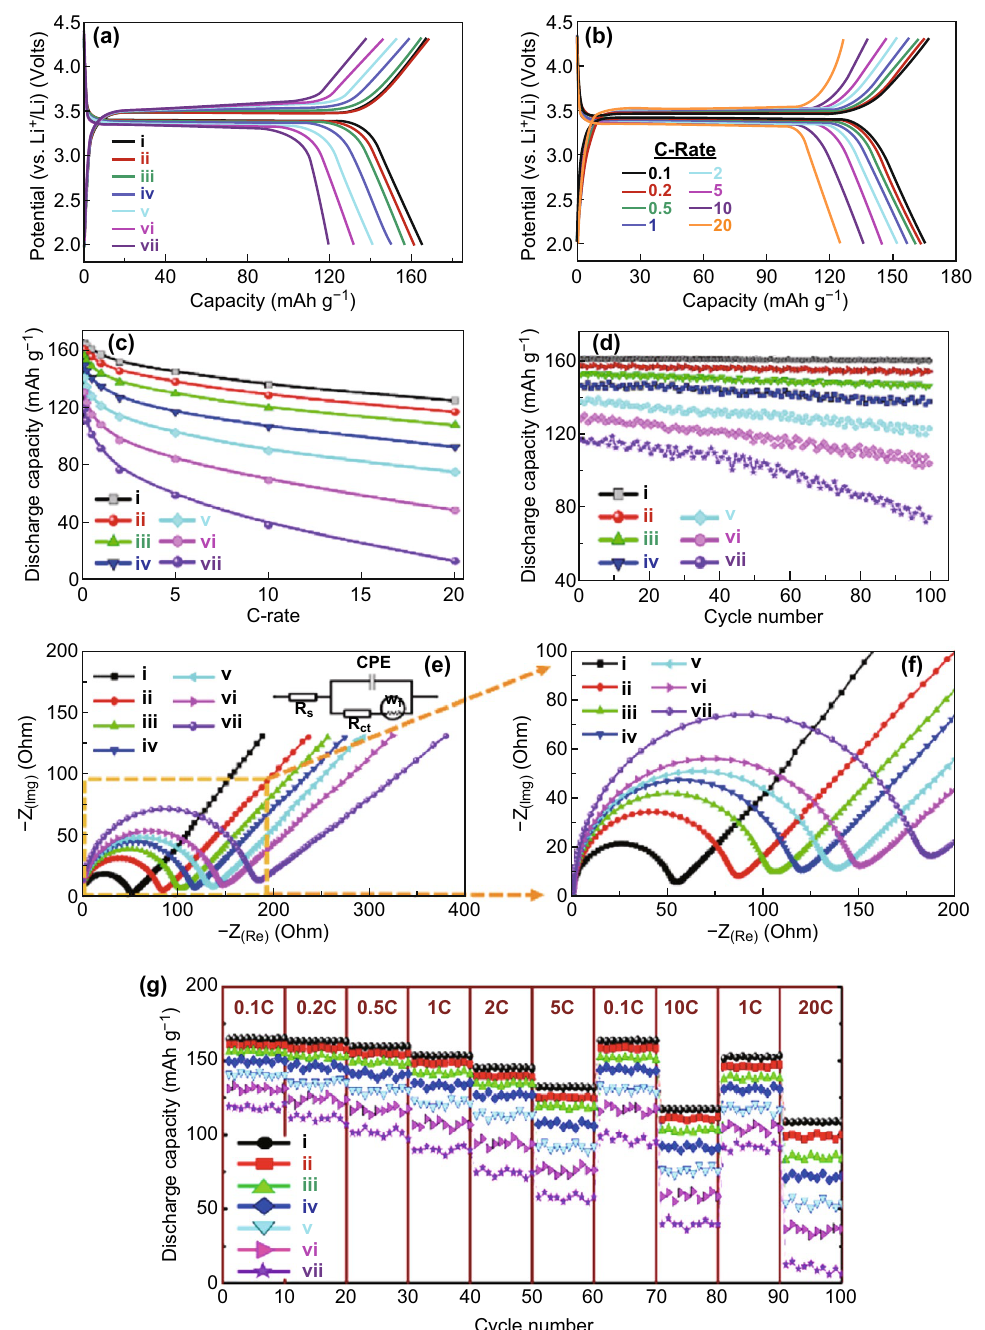
Fig. 4 a Charge–discharge voltage profiles of first cycle current rate 0.1 C half‑cell of the power cathode VST‑(i–vii)@C hierarchy designated in the half‑cell LIB model (2032 coin‑type half‑cell tests with a Li counter electrode). b The VST‑(i)@C hierarchy designated in the half‑cell LIB model at the first cycle comparison between half‑cells at different current rates varying from 0.1 to 20 C. c First discharge capacity of all power cathode VST‑(i–vii)@C hierarchies designated in the half‑cell LIB model at a current rate of 0.1 C. d Cycling performance (stability) for all power cathode VST‑(i–vii)@C hierarchies designated in the half‑cell LIB model at a rate of 0.1 C for 100 cycles. e The electrochemical impedance spectroscopy (EIS) result of the power cathode VST‑(i–vii)@C hierarchy designated in half‑cell LIB models; the inset of c is the equivalent circuit agreement with the impedance results of the EIS. f enlargement of the semicircle part of e . g Rate capability performance over a range of 2.0–4.3 V among all tested LFPO@C cathodes of different structures at various current rates from 0.1 to 20 C. All electrochemical measurements were operated within a voltage range of 2.0–4.3 V at room